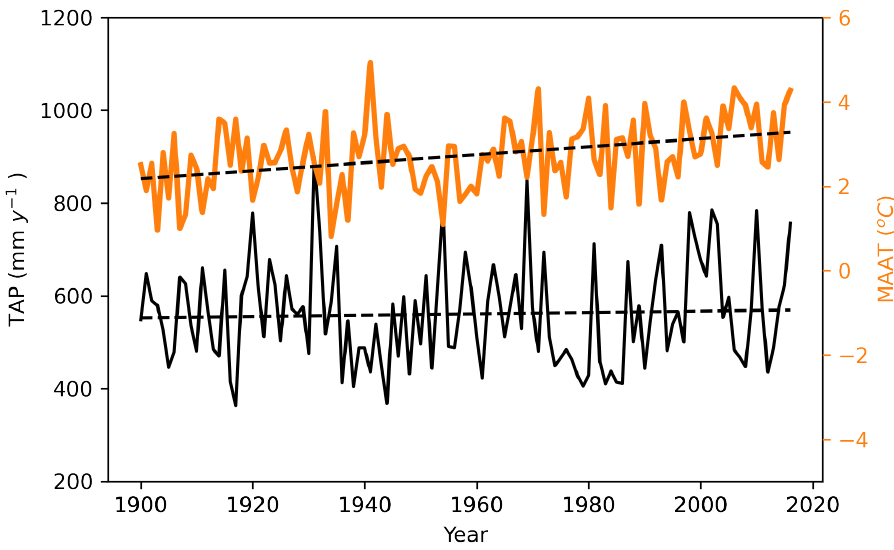
Figure 4. Bias corrected ERA20C Mean annual air temperature (MAAT) and total annual precipitation (TAP) for the study area. The time series is used to run the mass balance